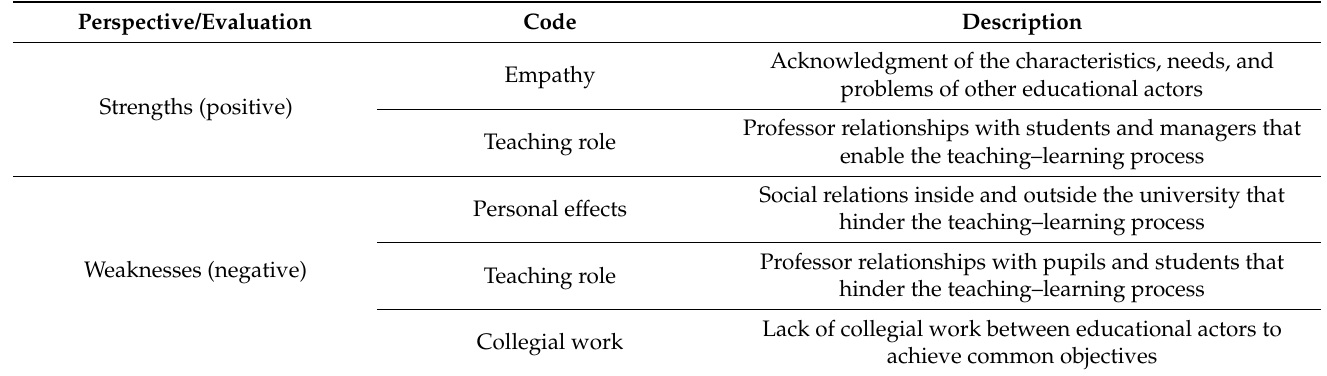
Table 5. Codes in the socio-political